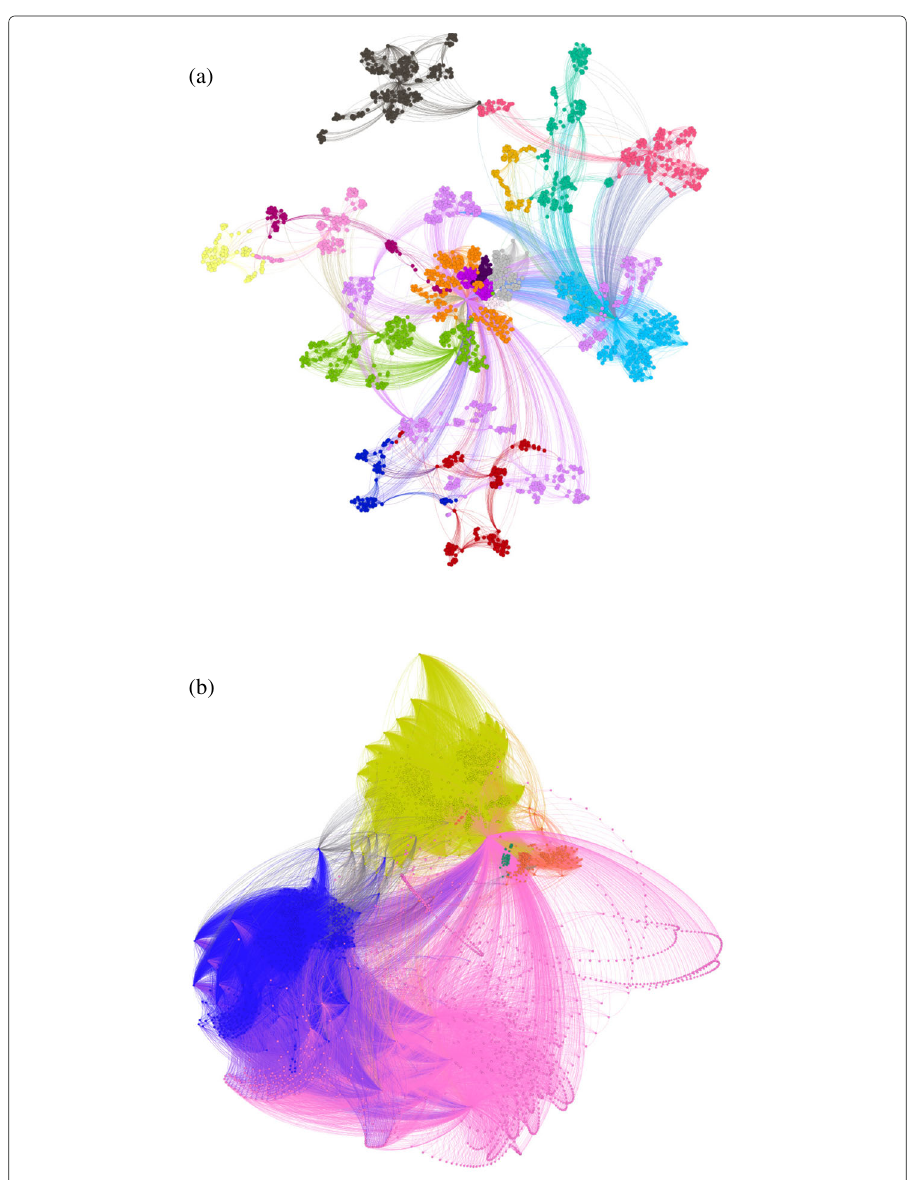
Fig. 3 Audio–Associated Visibility Networks of the series in Fig. 2a and b. The colours represent the modularity classes of each network. Q is the modularity, and Nc is the number of communities. Source: Author. a Percussive network (Q=0.790, Nc=17) b Symphonic network (Q=0.551, Nc=5)